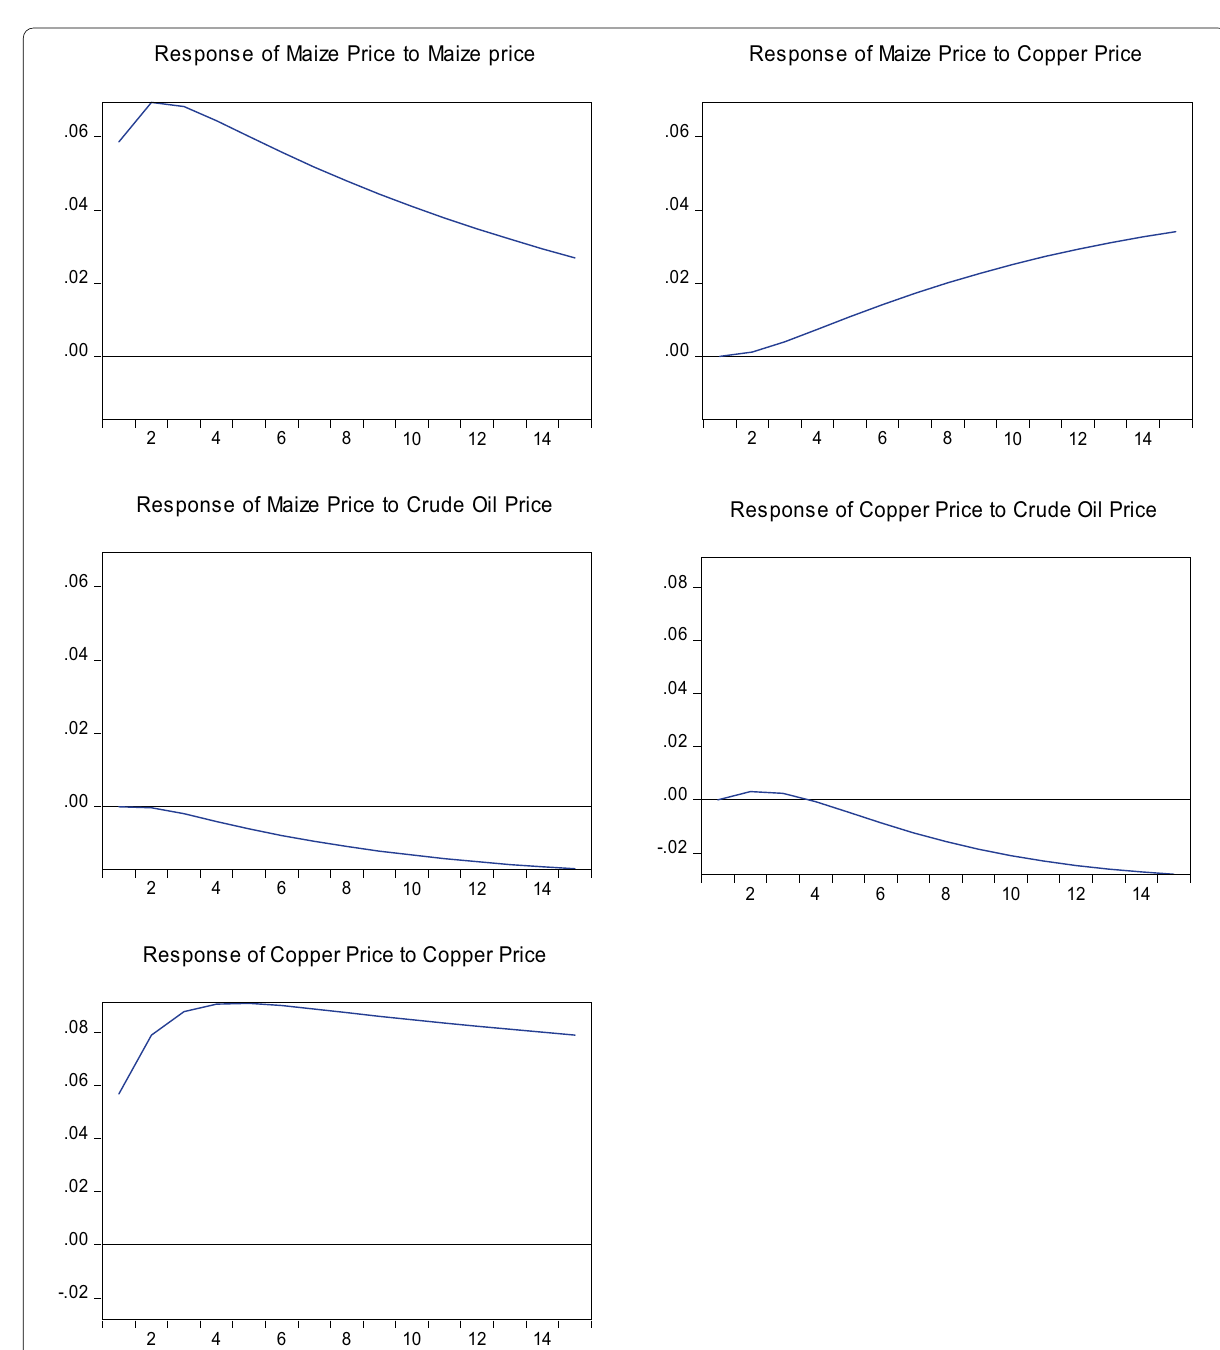
Fig. 4 Response of maize prices and copper prices to shocks from crude oil prices 2000 to